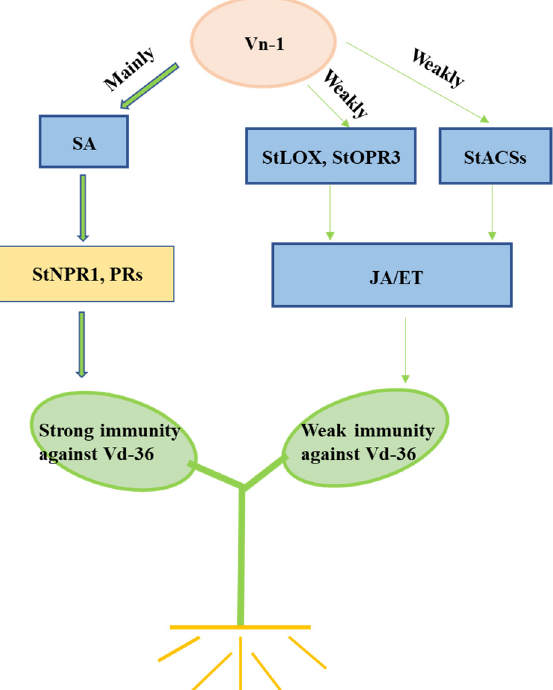
Figure 6. Network diagram of predicted Vn ‐ 1 ‐ induced resistance of potatoes against Verticillium dahl iae. Inoculation treatment with Vn ‐ 1 in advance mainly stimulated salicylic acid (SA) accumu ‐ lation and biosynthesis ‐ related genes ( StNPR1 , PRs ), and only slightly stimulated jasmonic acid (JA)/ethylene (ET) accumulation and related genes ( StLOX , StOPR3 / StACSs ) during induction of resistance to Vd ‐ 36 in potatoes.